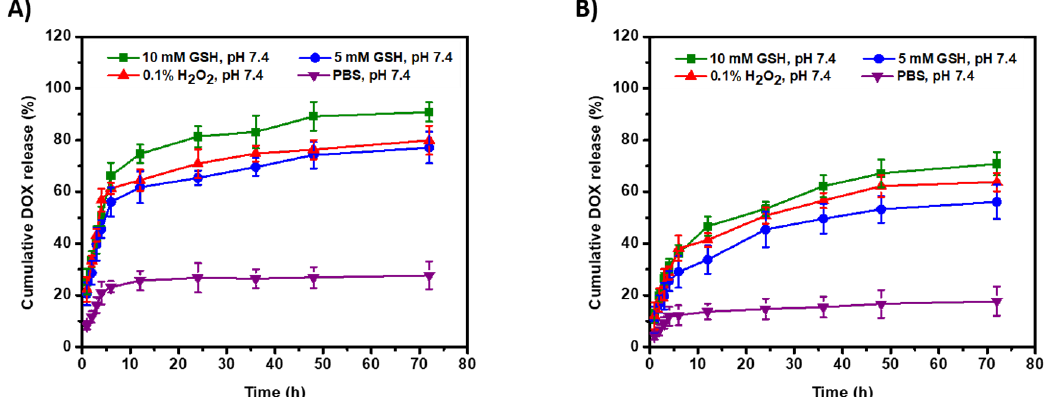
Figure 5. In vitro redox-responsive DOX releasing profile of DOX@NCMs ( A ) and DOX@CCMs ( B ) at 37 °C ( n = 3).